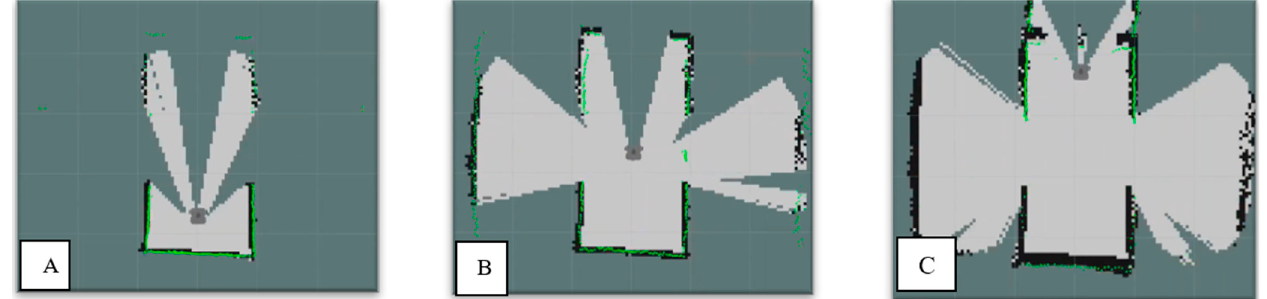
Figure 11. RViz map of test case 4 at positions ( A – C ) where the mobile robot travels in a multiple mirror environment with three plane mirrors.